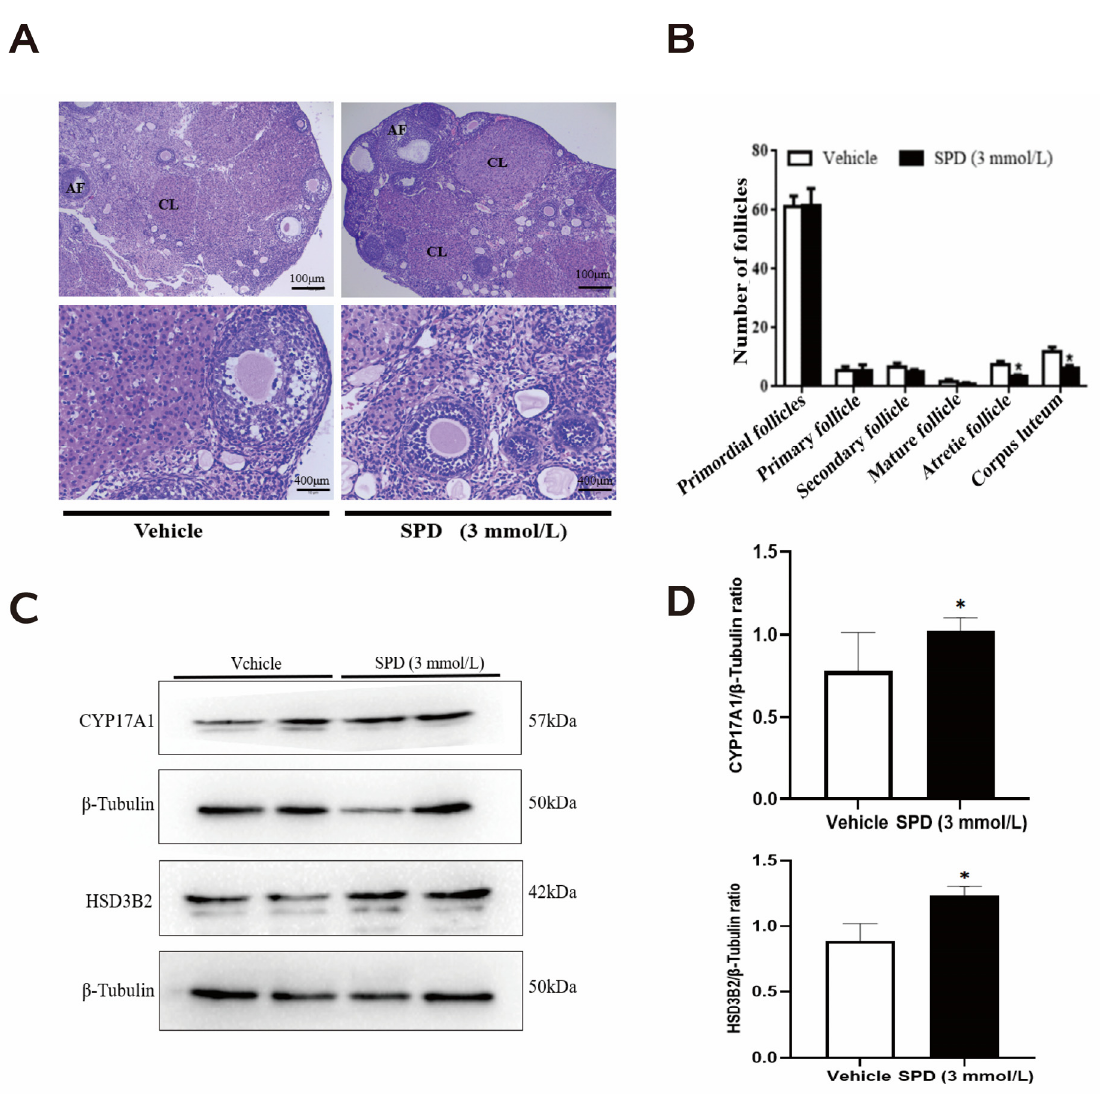
Figure 2. The effects of spermidine on ovarian histomorphology and follicular development in mice. ( A ) Hematoxylin and eosin (HE) staining. ( B ) Graph of the number of follicles in different developmental stages (AF: atresia follicle; CL: corpus luteum). ( C ) Western blot visualizing the expression levels of follicular development-related proteins. ( D ) Quantitative expression levels of follicular development-related proteins. The results shown are representative of three independent experiments. * p < 0.05 vs. control.